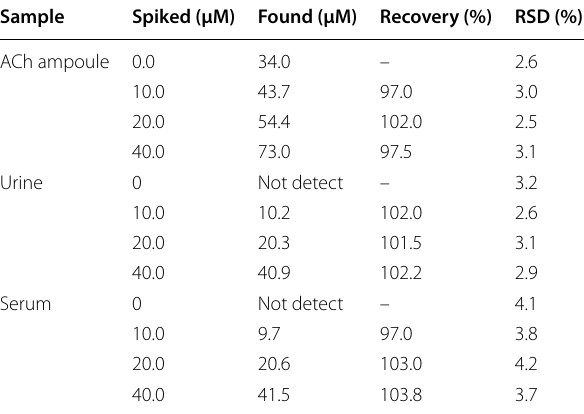
Table 1 Effect of interference in the determination Table 2 The application of MCSNP/SPE for